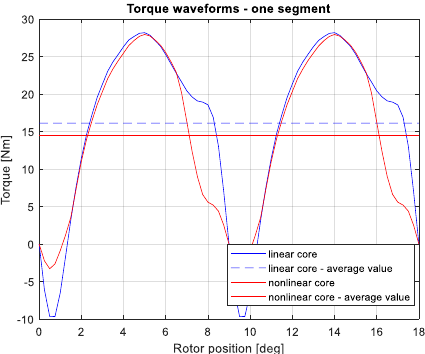
Figure 8. Comparison of torque waveform as a function of rotor position angle for the linear core and nonlinear core.